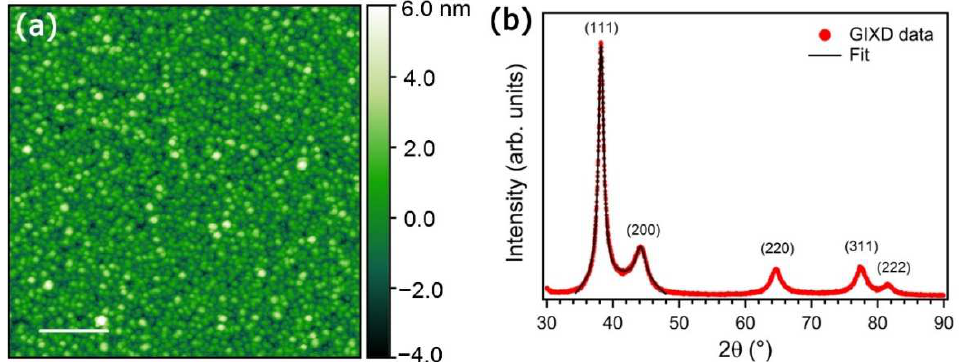
Figure 4. ( a ) AFM image of a 6-nm thick film deposited on a plain Si(100) wafer (original data). Scale bar = 200 nm. ( b ) Grazing-incidence X-ray diffraction taken on the Ag NP film. The reflections ascribed to polycrystalline Ag are reported together with the fit used to estimate the average grain size of the NPs. Adapted from the supporting information of [37] with permission.